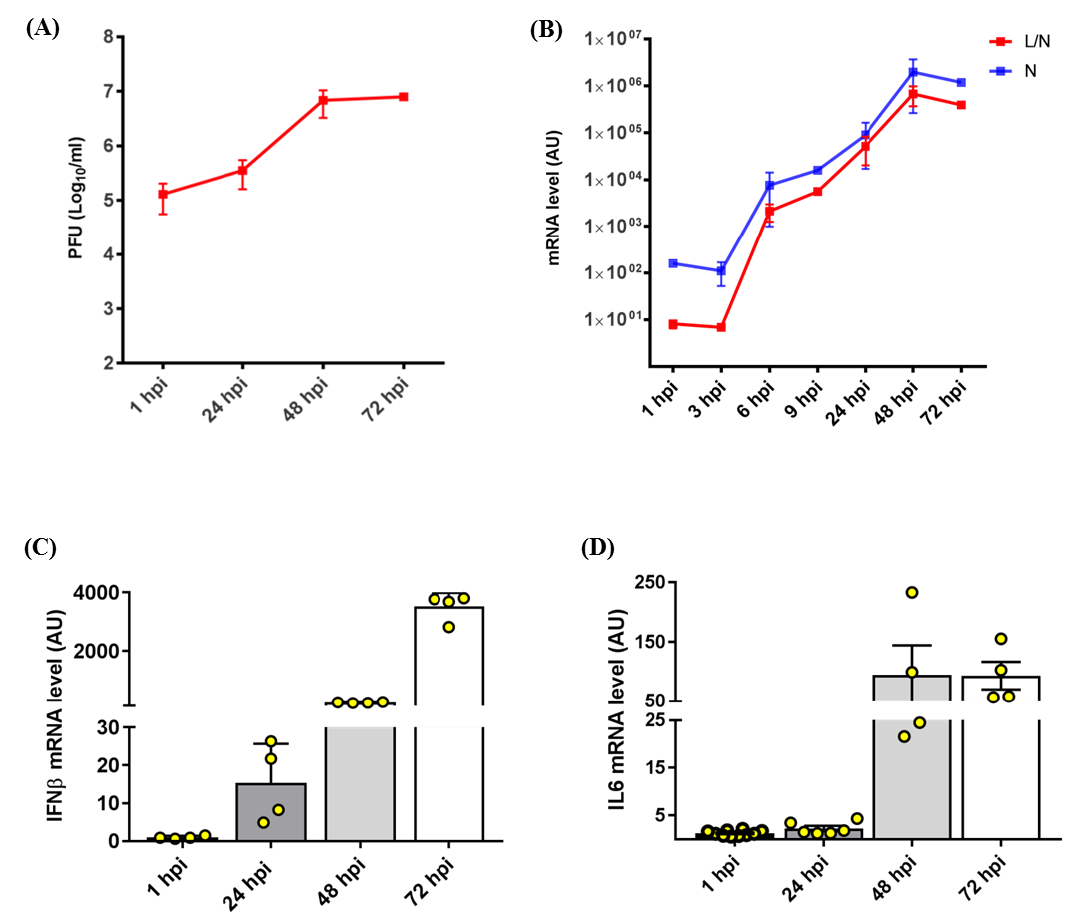
Figure 2. SARS-CoV-2 infection model in Calu3 cells. ( A ) Virus titer in SARS-CoV-2-infected Calu3 cells, expressed as plaque-forming units (PFU)/mL along time (hours post-infection, hpi). ( B ) Expression profile (arbitrary units, AU) of genomic (N) and subgenomic (L/N) viral sequences in SARS-CoV-2-infected Calu3 cells, assessed by qRT-PCR at different time points. The mean of two or five independent experiments ± standard error of the mean (SEM) is indicated for each time point. ( C ) Expression levels (arbitrary units, AU) of the inflammatory cytokines IFN- β and ( D ) IL6 in infected versus non-infected Calu3 cells at different time points (hours) post-infection. Each bar represents the mean of two or five independent experiments ± SEM. Infected cells were compared with non-infected Calu3 cells for each time point. One-way ANOVA with the Bonferroni multiple comparison test.